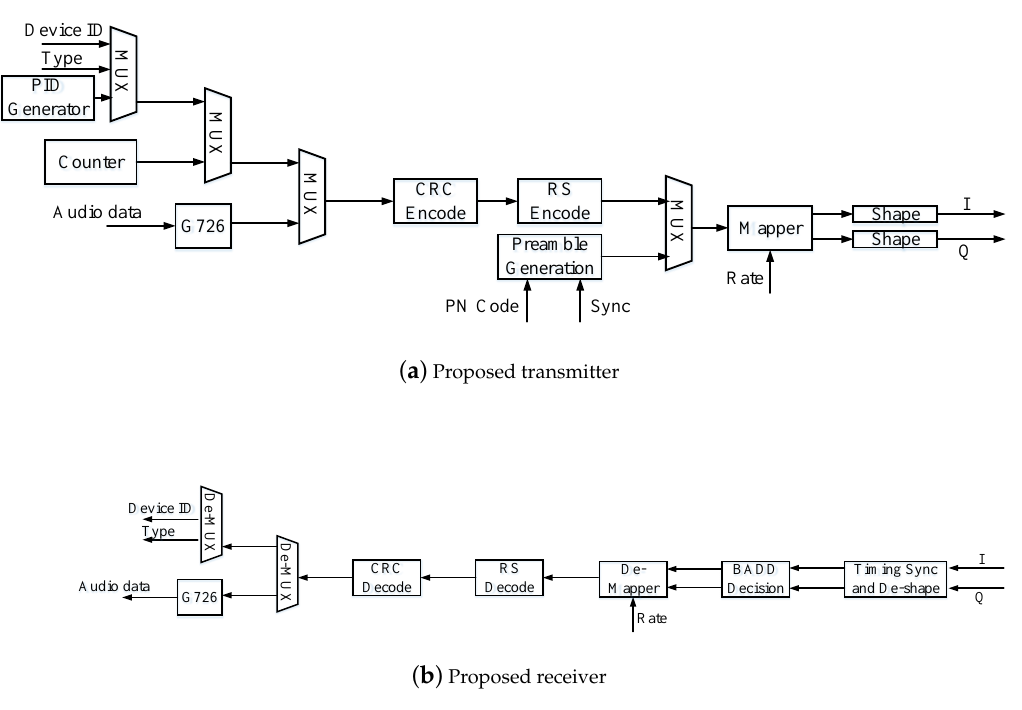
Figure 11. Proposed diagram of the system data exchange